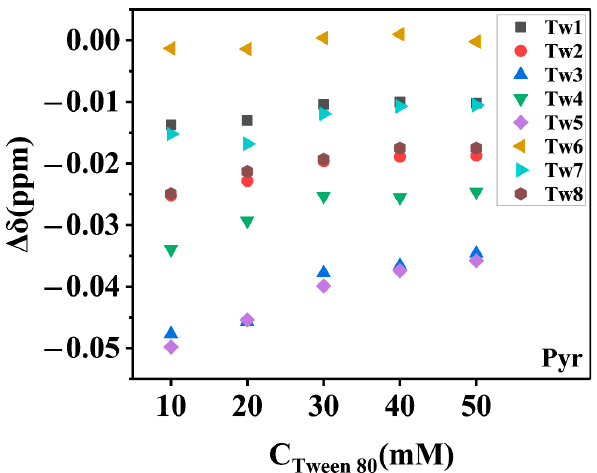
Figure 4. Relative chemical shifts ( ∆δ ) of Tween 80 protons in the single Pyr solubilization system at Tween 80 concentrations from 10 to 50 mM compared to those of the pure Tween 80 solution at the same concentration.